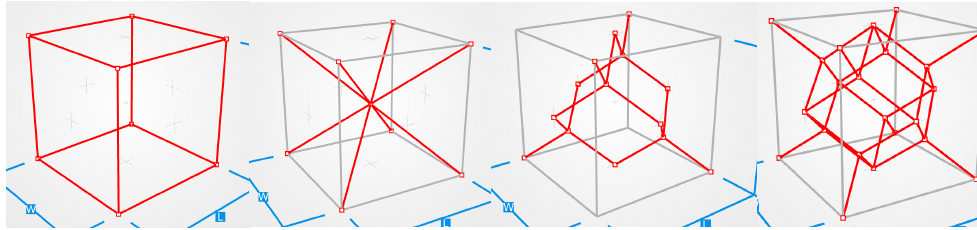
Figure 14. For a given tessellation and element, there are several ways to establish connectivity, as shown here for a cubic, beam element unit cell (screenshots from nTopology Element software [21]).